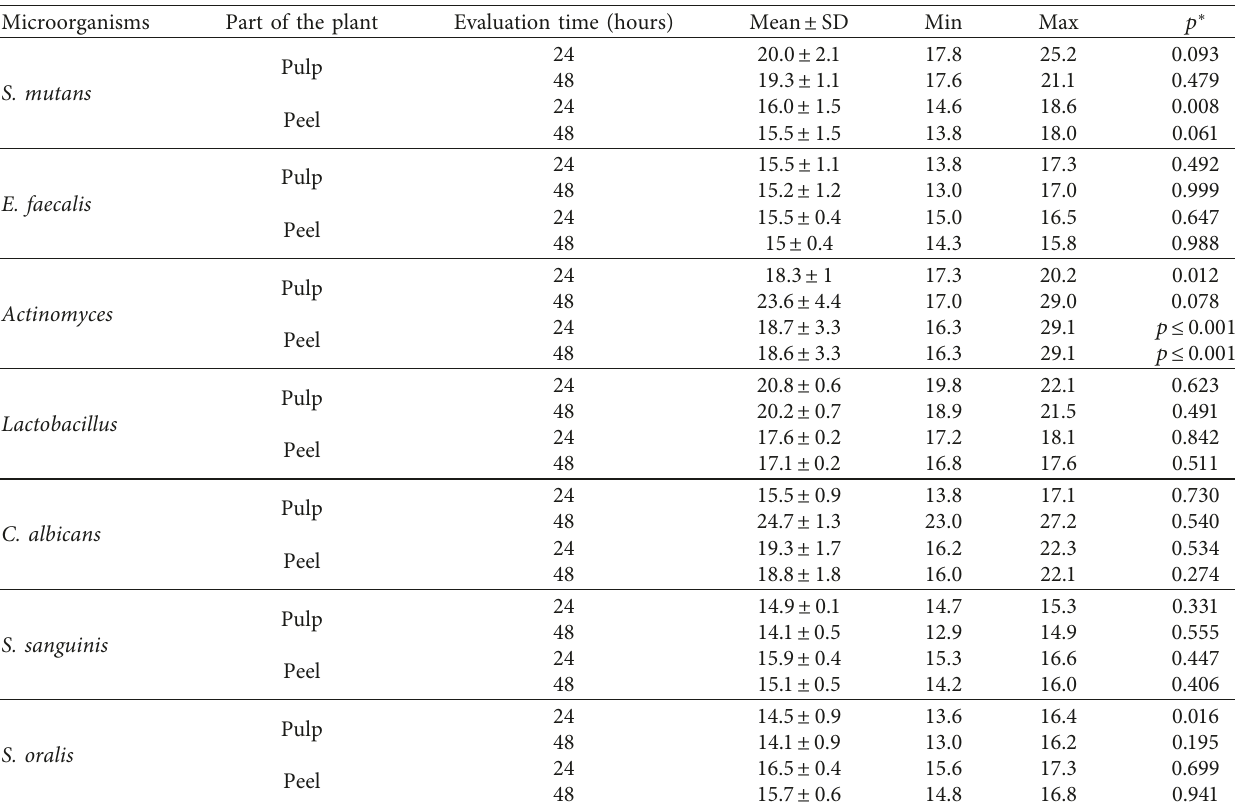
Table 2: Comparison of the antimicrobial activity of tumbo dentifrice against seven strains of the oral cavity (formulation without fluoride). Microorganisms Part of the plant Evaluation time (hours)